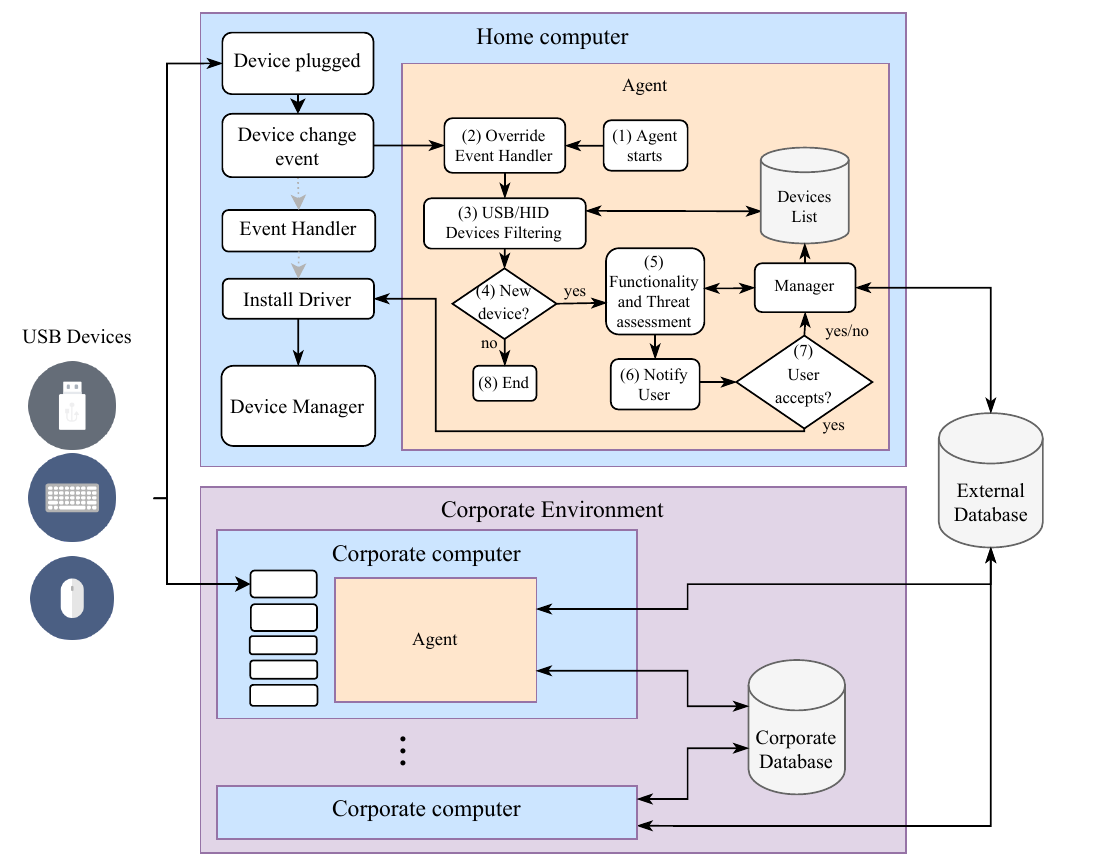
Figure 2. Detailed schema for the distributed protection